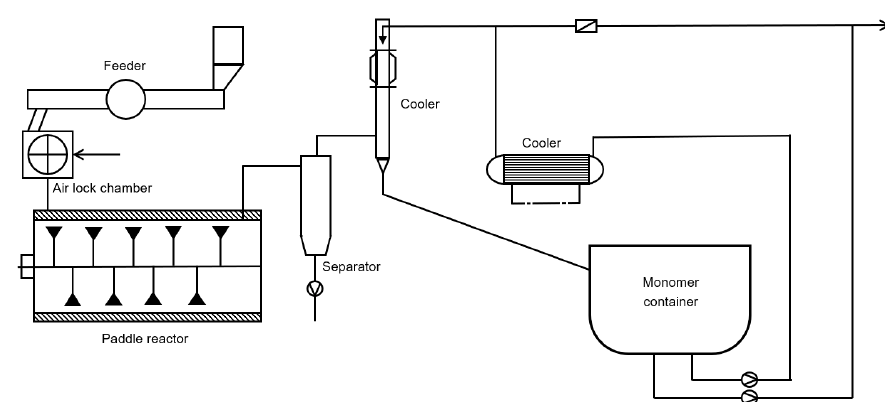
Figure 20. Patented depolymerization technology by Schola et al. in which use is made of a paddle reactor [131] .